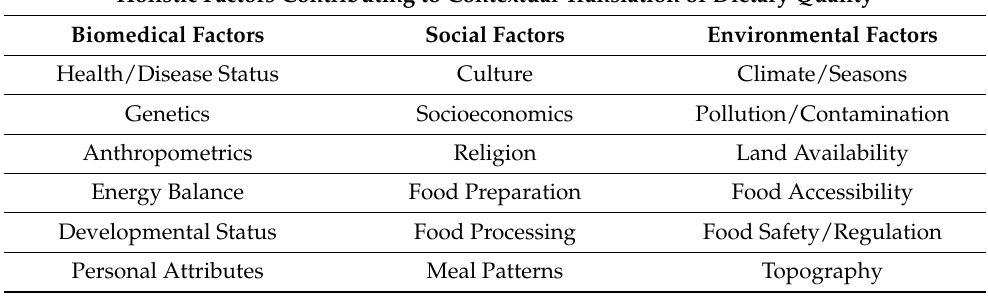
Table 2. Holistic Factors Contributing to Translation of Dietary